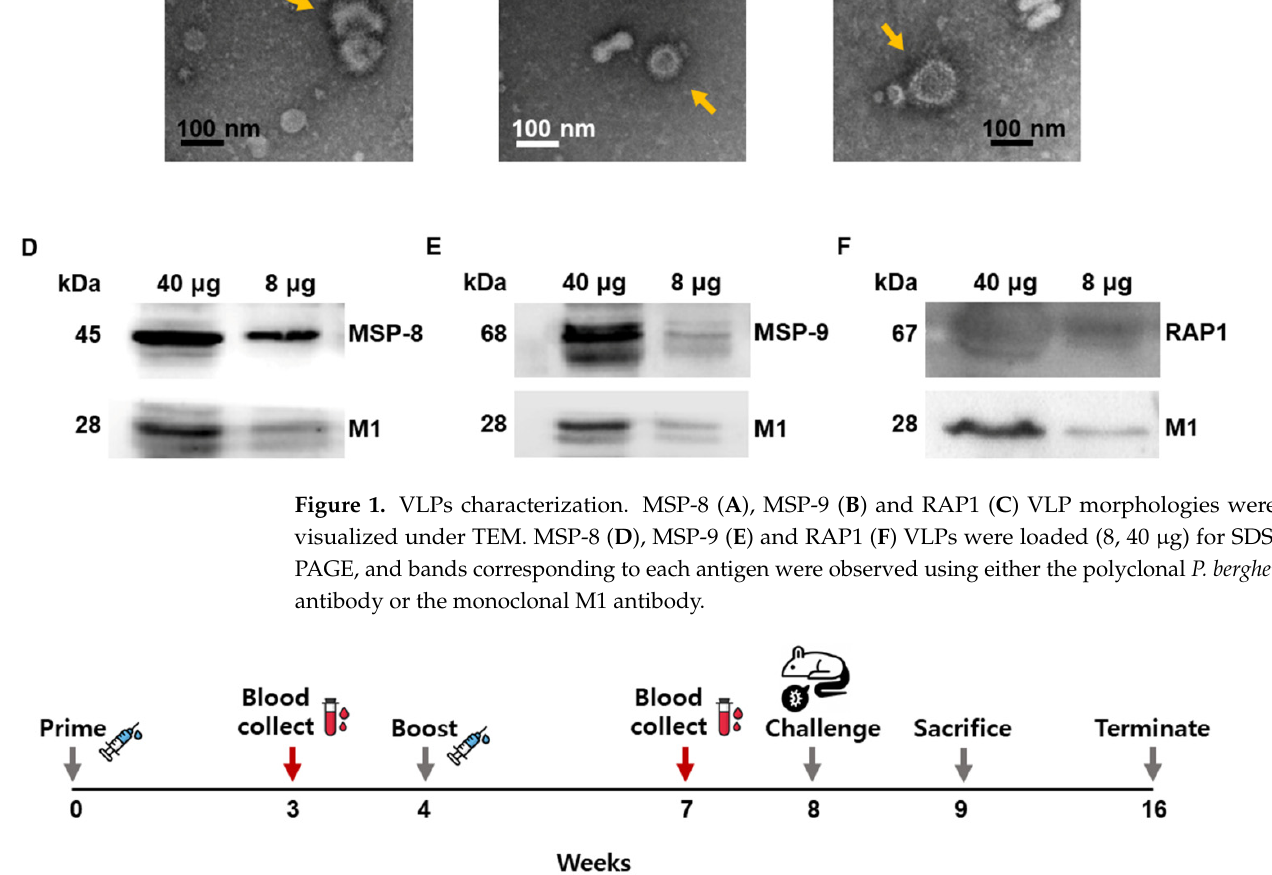
Figure 2. Experimental schedule. Mice were immunized twice with the combined VLP vaccines expressing MSP-8, MSP-9, and RAP1 of P. berghei at 4 weeks intervals, and blood samples were drawn 3 weeks after each immunization. Challenge infection was performed 4 weeks after boost immunization and half of the mice in each group were sacrificed at 1 week post-challenge.